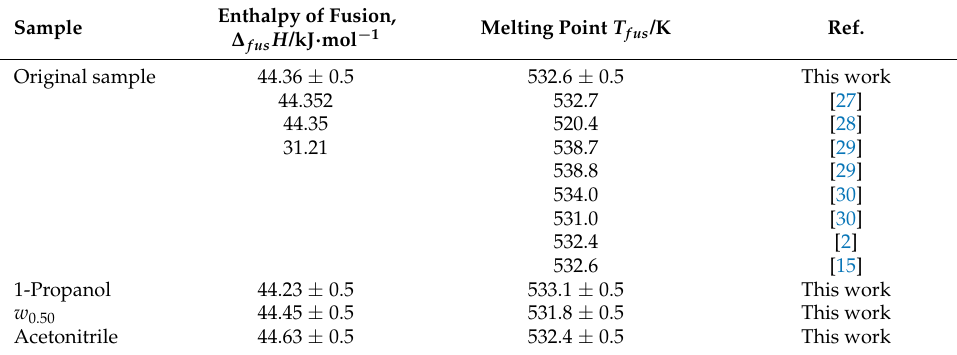
Figure 2. DSC thermograms of sulfadiazine. Table 3. The thermophysical properties of SD obtained by the